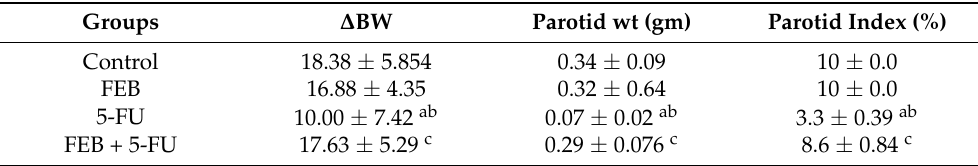
Table 1. Impact of FEB on the physical parameters ( ∆ BW, parotid wt, and parotid index) of 5-FU- induced injury of the parotid salivary gland in rats.